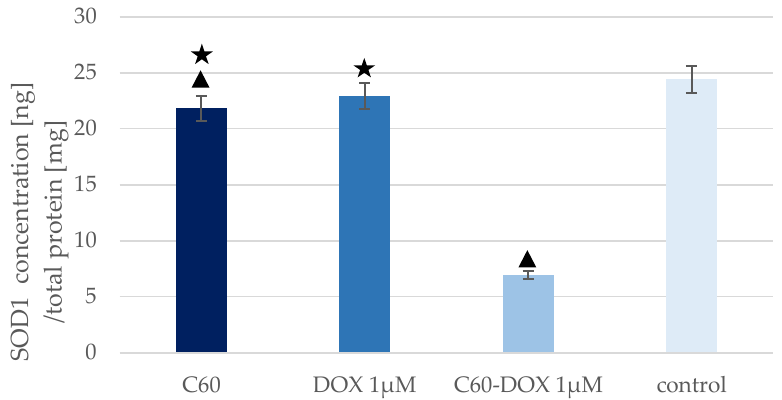
Figure 4. SOD1 levels in MCF-10A cells treated with C 60 , DOX and C 60 – DOX complexes. The triangle marks a statistically significant difference compared with the control ( p < 0.05). The asterisk marks statistically significant differences compared with the C 60 – DOX ( p < 0.05).